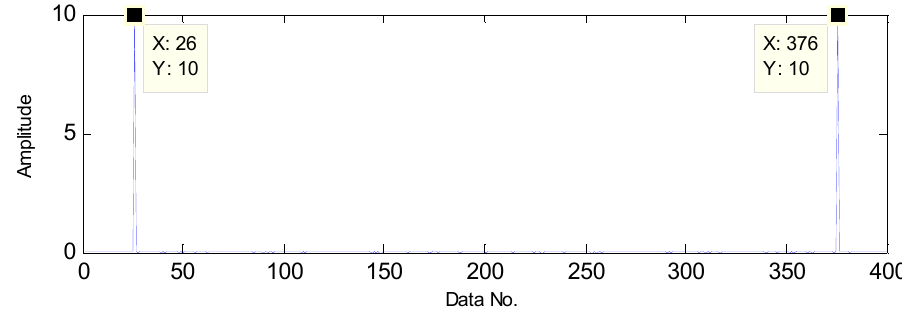
Figure 6. The sparsity of the harmonic signal in the Fourier domain.